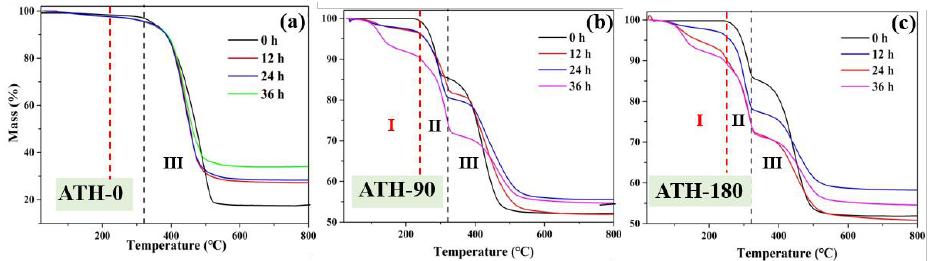
Figure 9. TG curves of ATH-0 SiR ( a ), ATH-90 SiR ( b ), and ATH-180 SiR ( c ) after NO 2 aging for different times.